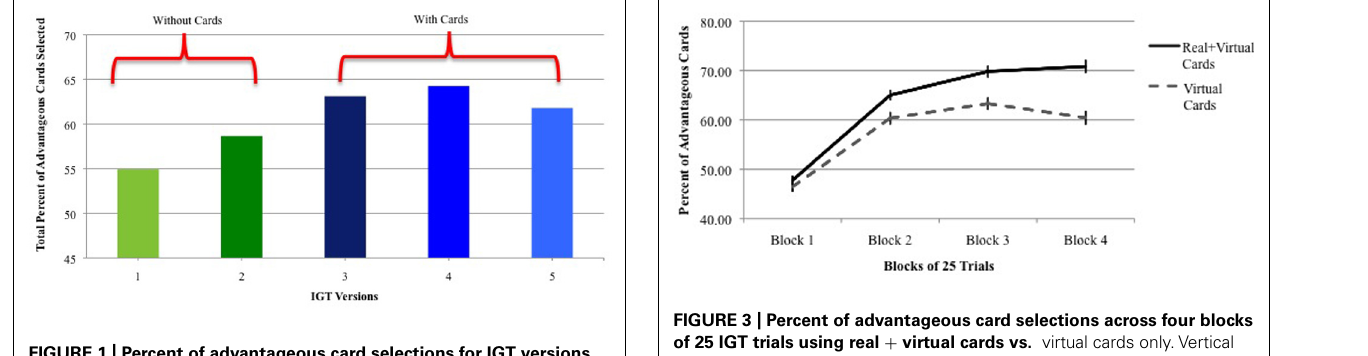
FIGURE 1 | Percent of advantageous card selections for IGT versions that used only virtual cards (Versions 1 and 2) and versions that used real + virtual cards (Versions 3–5). Vertical bars indicate standard error of the mean (SEM).